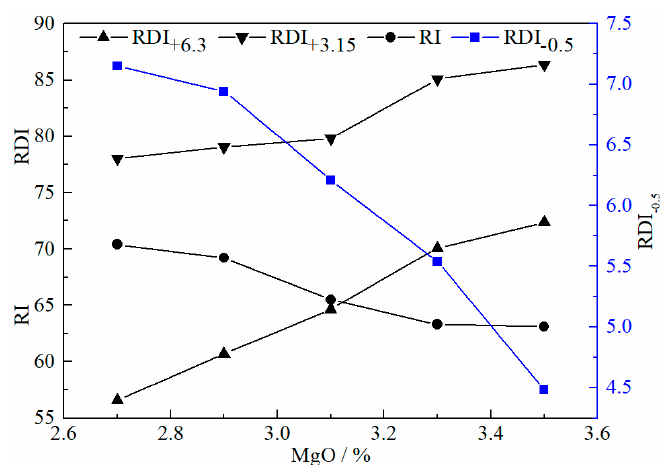
Figure 7. Reduction degradation index (RDI) and reduction index (RI) of the HTCVM sinters with different MgO contents.